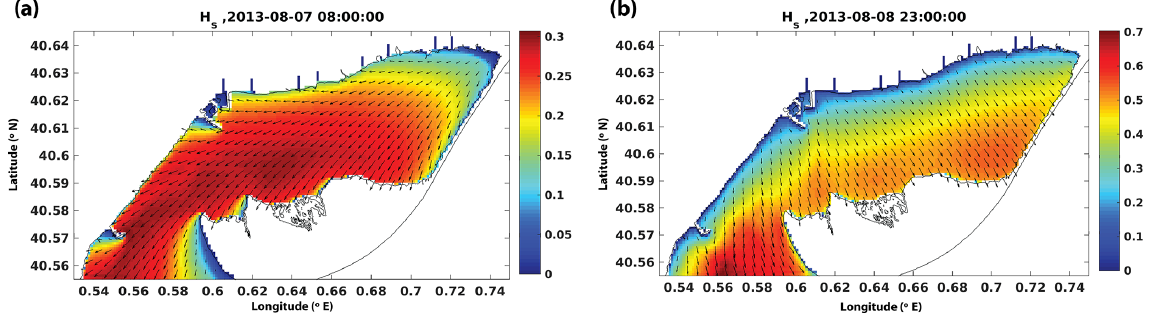
Figure 7. Wave field for the E2 (sea breeze; a ) and E3 (northwesterly wind; b ) episodes. The colours represent the significant wave heights in metres, and black arrows denote the direction of propagation. Note that the value ranges of colour bars are different.